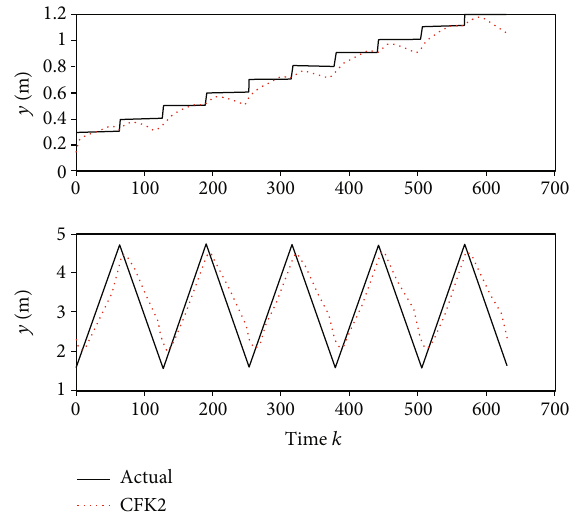
Figure 4: State estimation results after adaptive system noise